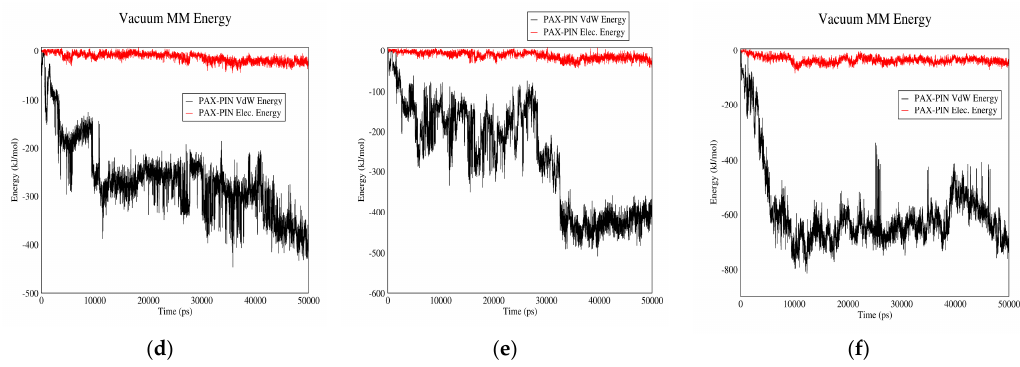
Figure 8. Electrostatic and Van der Waals energies of PAX–PIN interaction versus time in neutral and acidic pH for different carriers: ( a ) CNT in neutral pH; ( b ) Fullerene in neutral pH; ( c ) GO in neutral